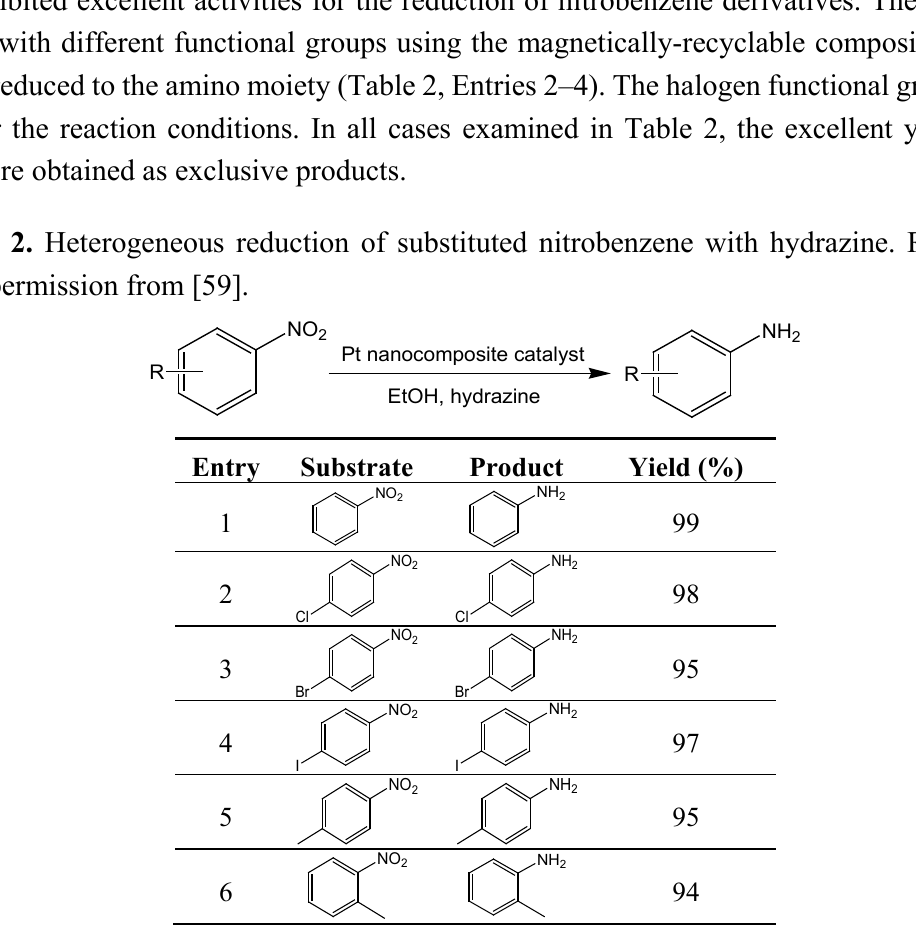
Table 2. Heterogeneous reduction of substituted nitrobenzene with hydrazine. Reprinted with permission from [59]. NO 2 R